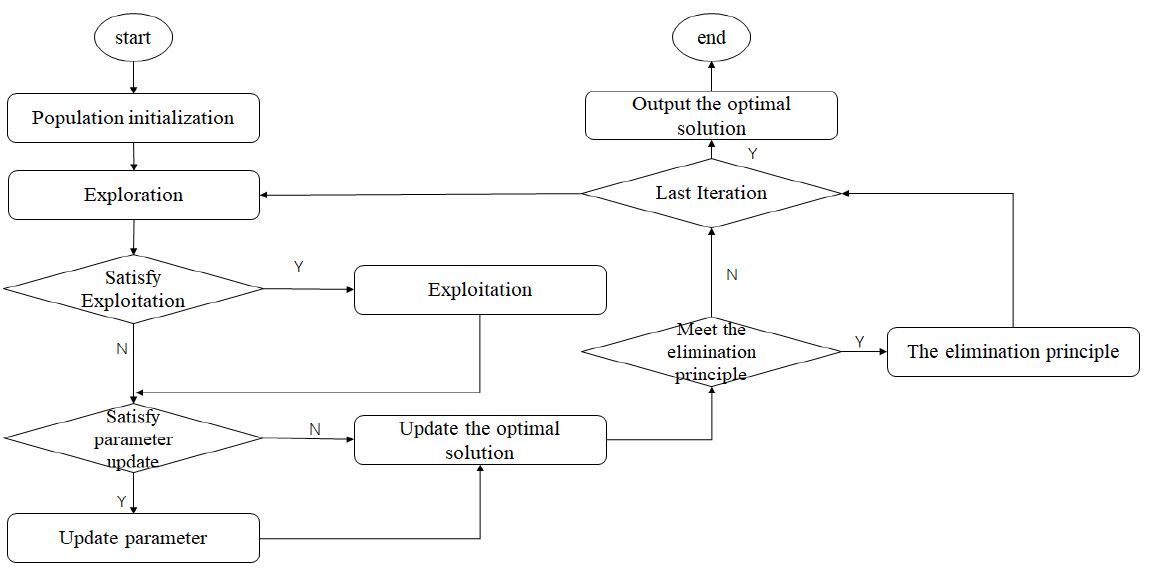
Figure 3. The flow chart of MDBA.